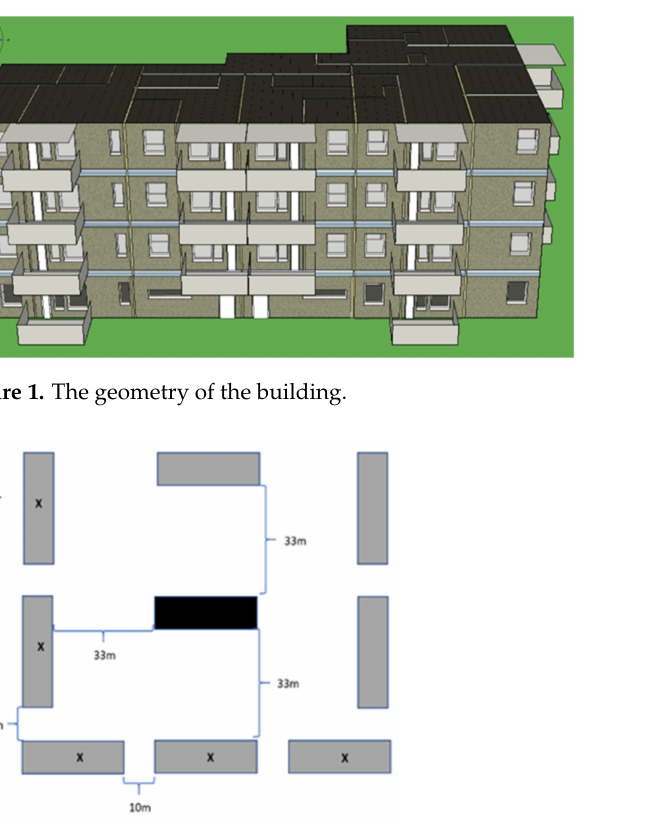
Figure 2. The location of the simulated example building (black box) and the surrounding buildings (grey